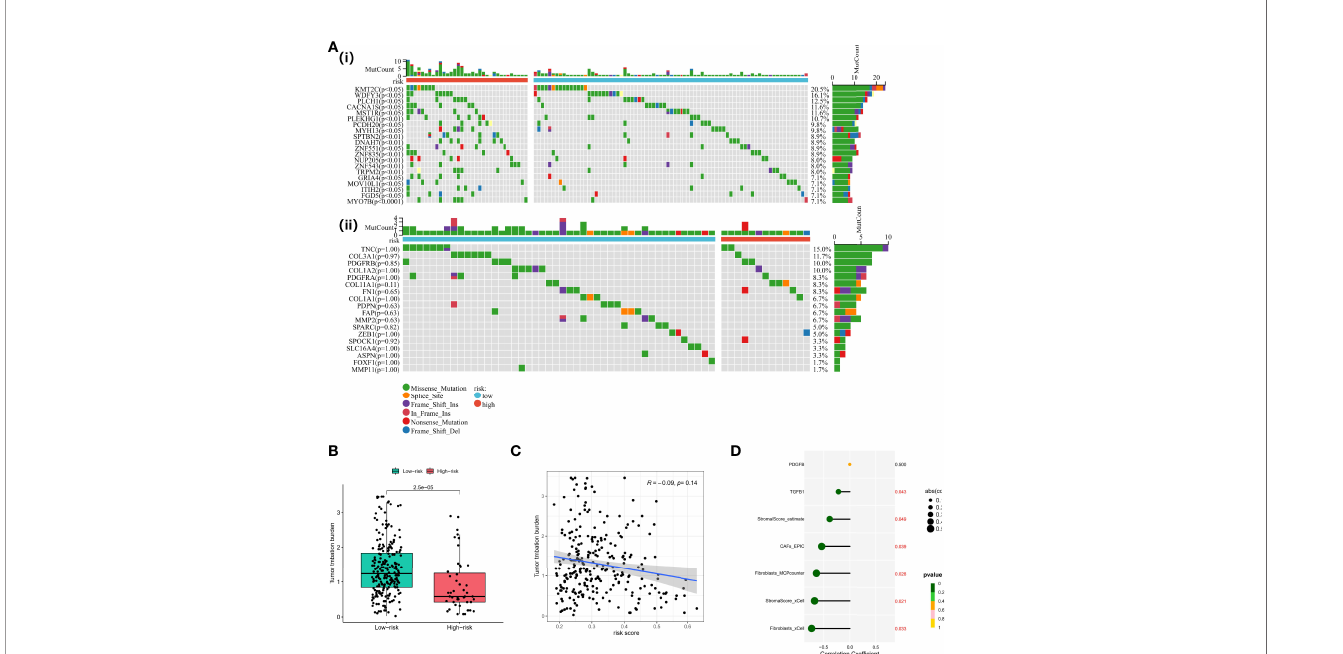
FIGURE 7 | Functional analyses and construction of the CAF-based signature. (A) (i) Differentially mutated genes in different risk groups. (ii) CAF marker mutations in different risk groups. (B) TMB values in different risk groups. (C) Spearman analysis between CAF risk score and TMB values. (D) Correlation analysis between TMB values, stromal/CAF scores, and CAF-activating factors. CAFs, Cancer-Associated Fibroblasts; TMB, Tumor Mutational Burden.